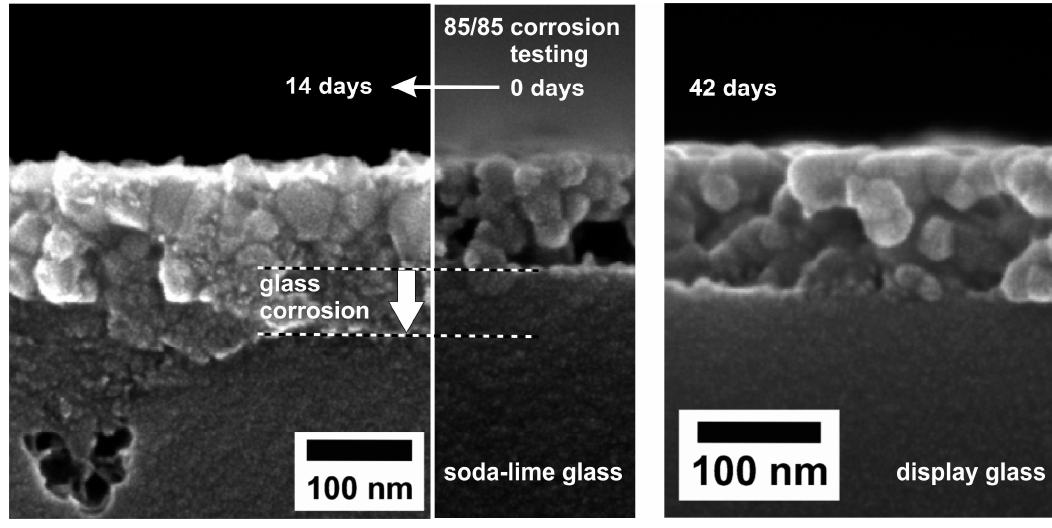
Figure 14. SEM cross-sectional views of MgF 2 thin films on different glass. Based on [41].